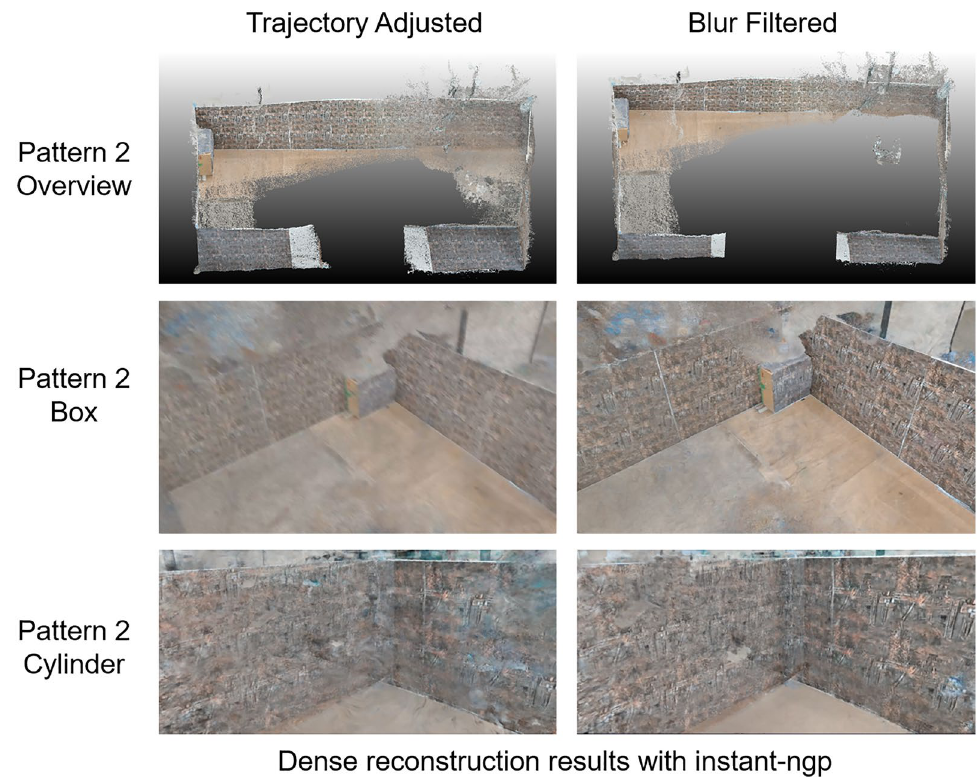
Fig. 15 Reconstruction results by instant-ngp with trajectory-adjusted dataset (left) and blur filtered dataset (right) under setup pattern